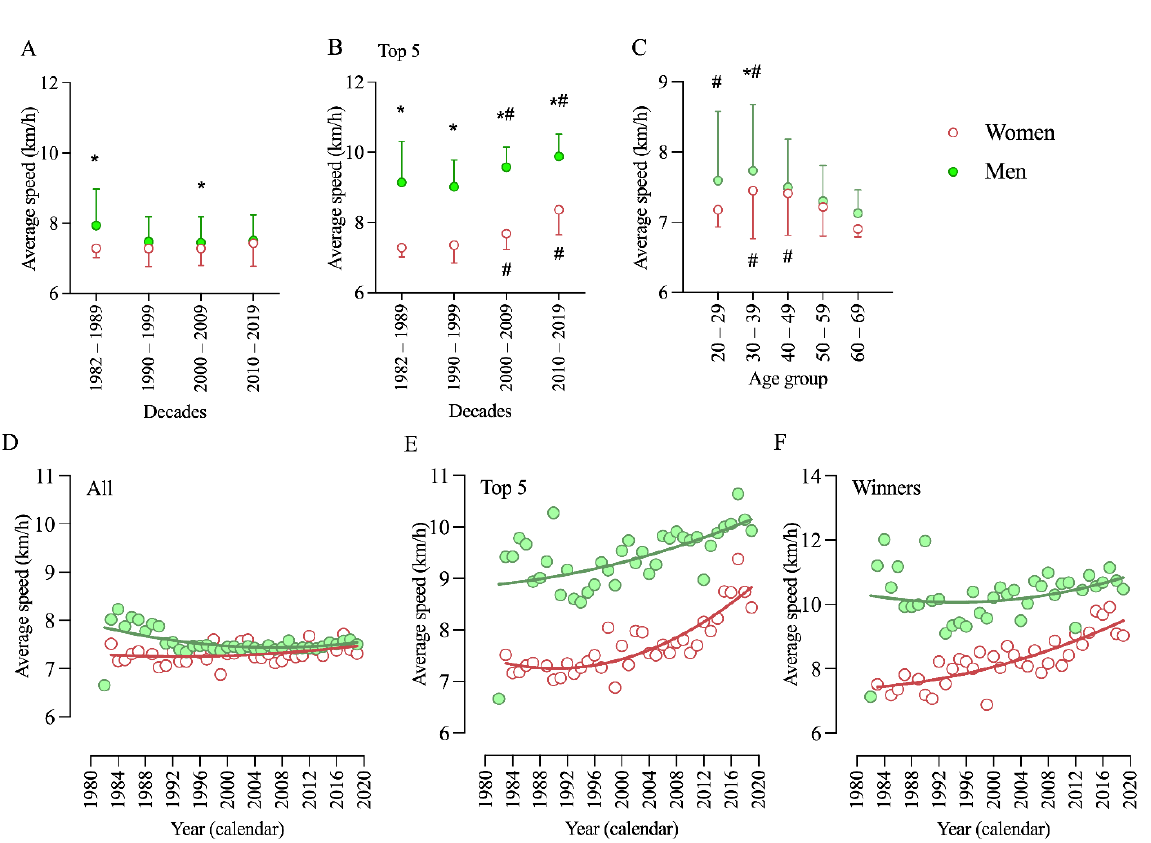
Figure 2. Performance trends in the Spartathlon across decades and age groups. *: statistically significant difference between men and women; #: statistically significant difference between decade or age group ( p < 0.05). ( A ) Spartathlon performance of men and women by decade; ( B ) Spartathlon performance of men and women top-5 finishers by decade; ( C ) Spartathlon performance of men and women by age group; ( D ) nonlinear regression of men and women performance by calendar year; ( E ) nonlinear regression of performance by calendar year of men and women top-5 finishers; ( F ) nonlinear regression of performance by calendar year of the winners in each race.